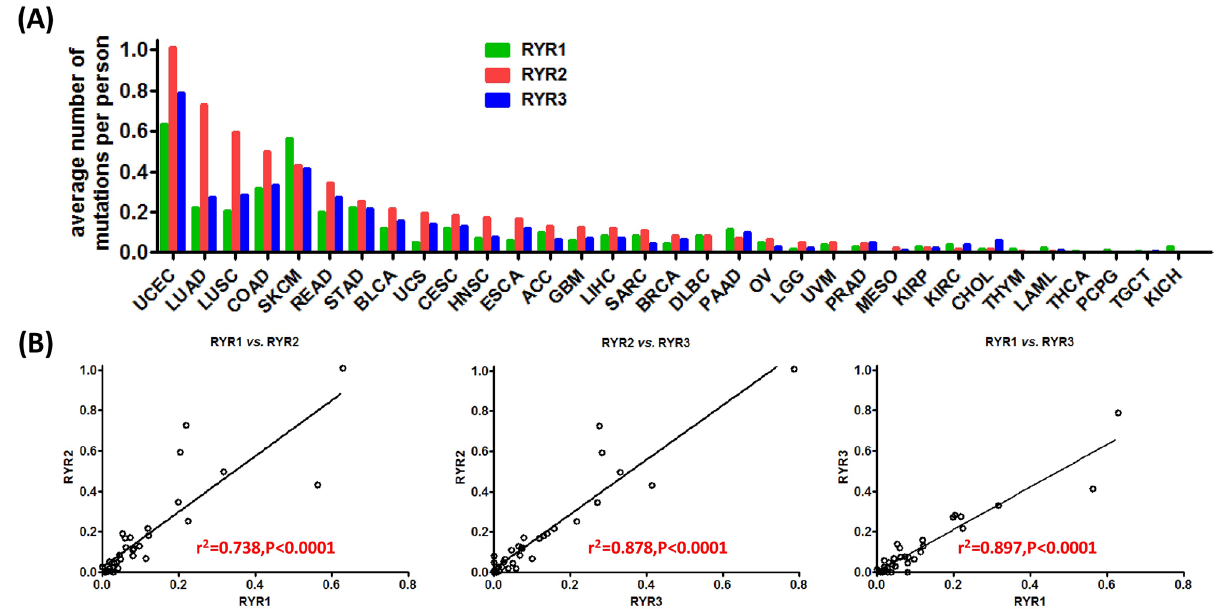
Figure 6. Comparison of average number of mutations and correlation of average number of mutations between RYR subtypes. Top panel: the average number of mutations per person of RYR1, RYR2 and RYR3 is compared for each cancer type, ranked by the average number of mutations of RYR2. Bottom panel: correlation of average number of mutations between any two RYR subtypes for all cancer types. Correlation coefficient (r 2 ) and P values are labeled for each